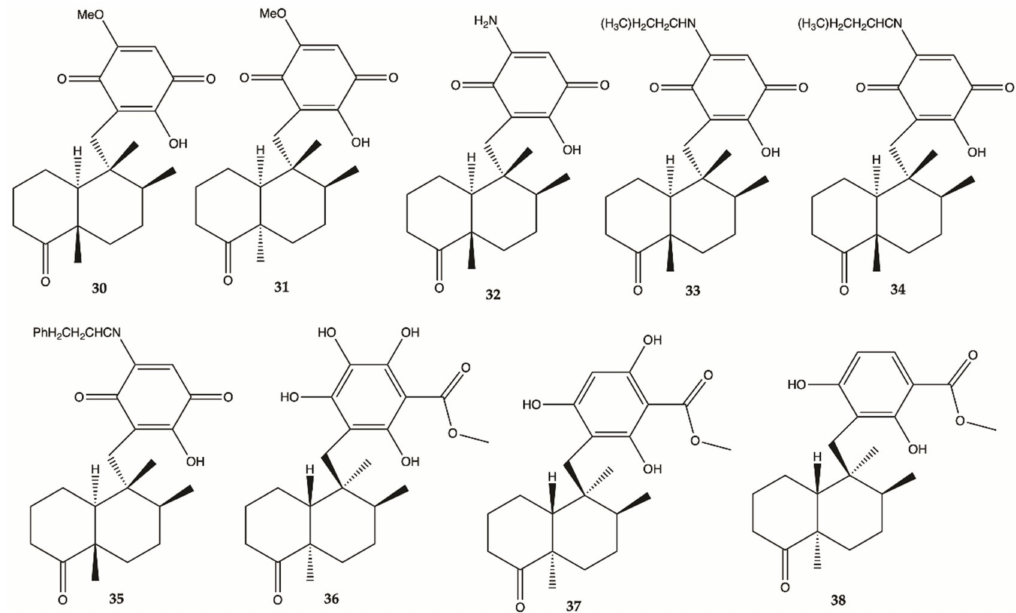
Figure 14. Sesquiterpenes 30 – 38 isolated from extracts of the Hawaiian marine sponge Dactylospongia elegans [53]. Compound 39 was isolated from a marine sponge Haliclona tubifera , which is abundant species on the southern Brazilian coast (Figure 15). This compound showed a cytotoxic effect in human glioma cell lines (U87MG), with a value lower than IC 50 < 15 µ g/mL [54].